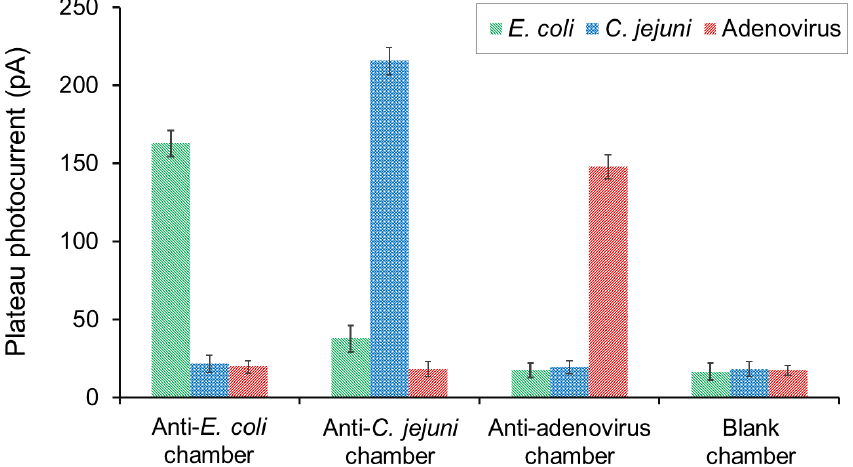
Figure 5. Cross- reactivity tests Detection of each pathogen was tested in four chambers, and the photocurrent measurements were performed in